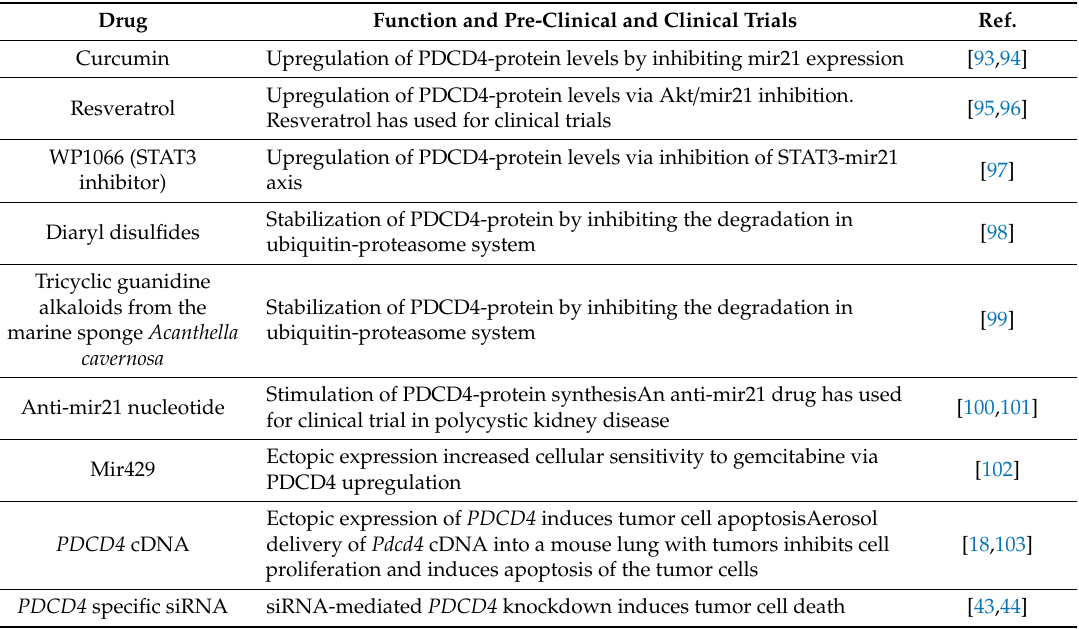
Table 3. Possible anti-tumor drugs associated with